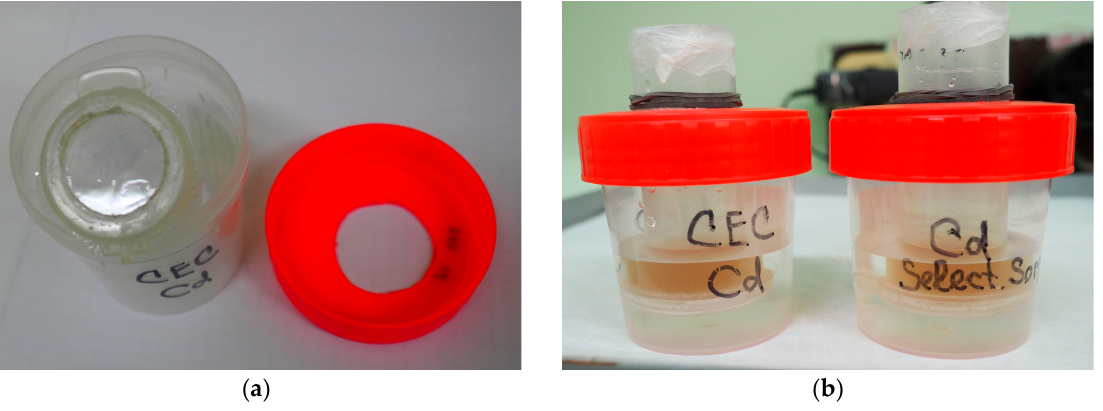
Figure 4. Determination of the cation exchange capacity (CEC) and selectivity coefficients K s Cd/Ca of a HMWDOM sample (3.5 kDa): ( a ) The general view of a dialysis tube with a “window” made of a MEMBRA-CEL membrane (3.5 kDa) and an external container; ( b ) The completed assembly (inside the dialysis tubes there is a suspension of 30 mg of HMWDOM (3.5 kDa) + 10 cm 3 of the equilibrating solution).